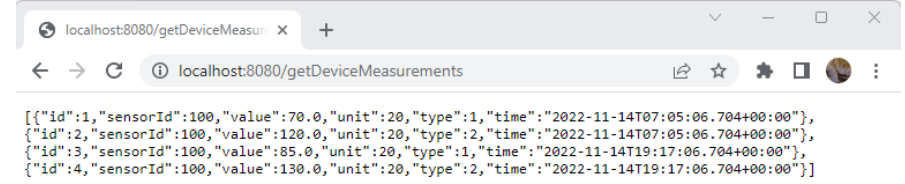
Figure 11. Access the web service getmeasurement.